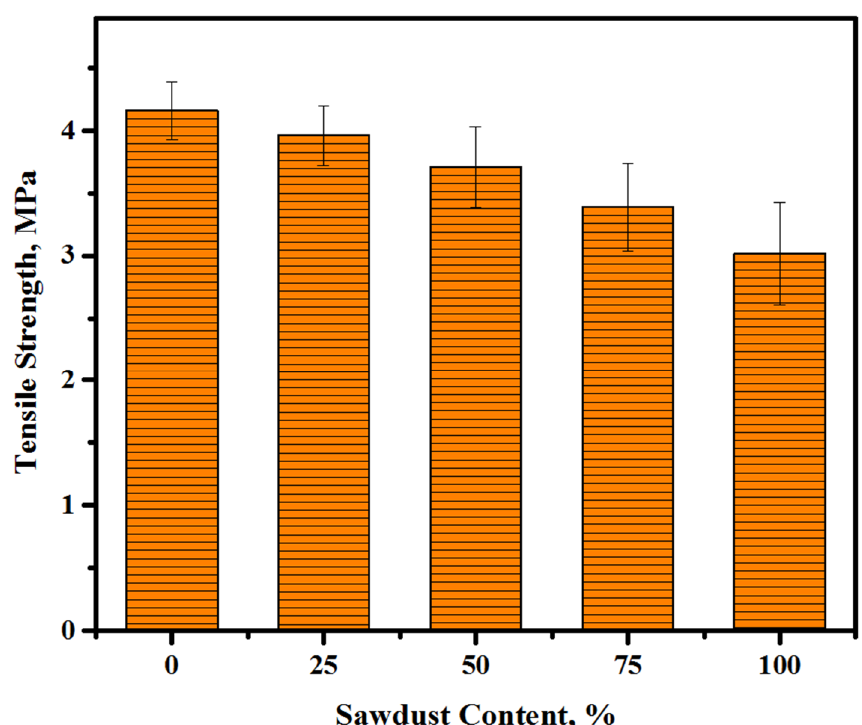
Figure 11. The STS of the LWCs against the sawdust contents.